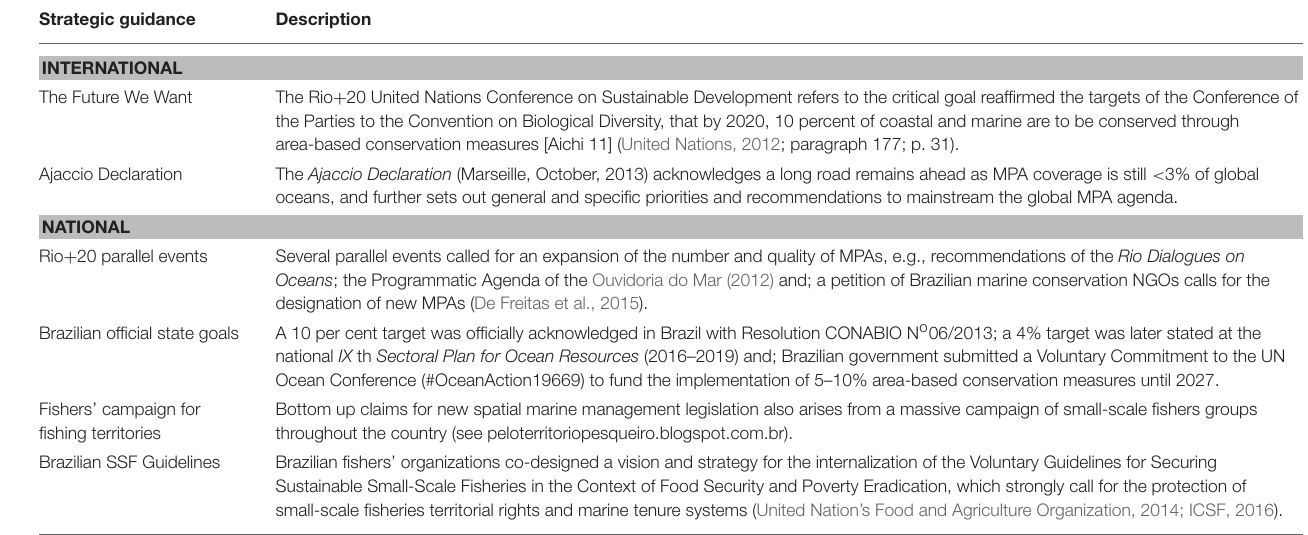
TABLE 1 | An illustrative sample of multi-level, synergistic, or mutually supporting strategic intentions toward area-based ocean governance systems reforms in